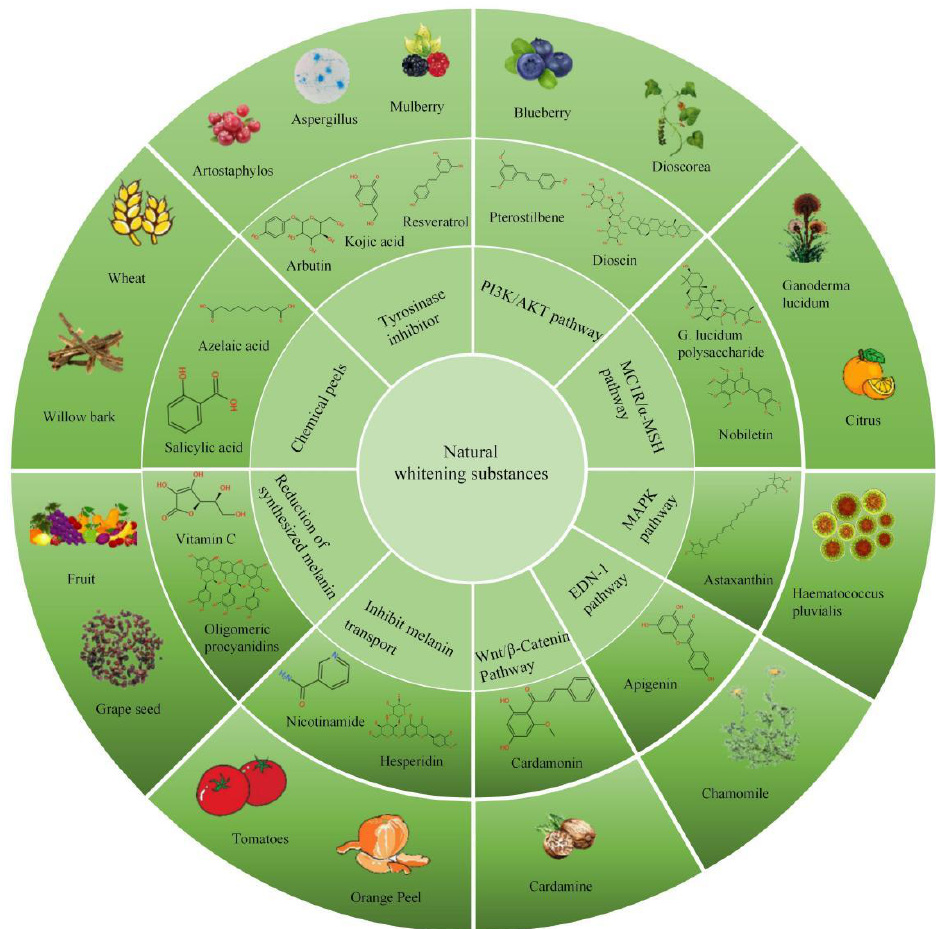
Figure 3. Natural whitening substances that act through different pathways.